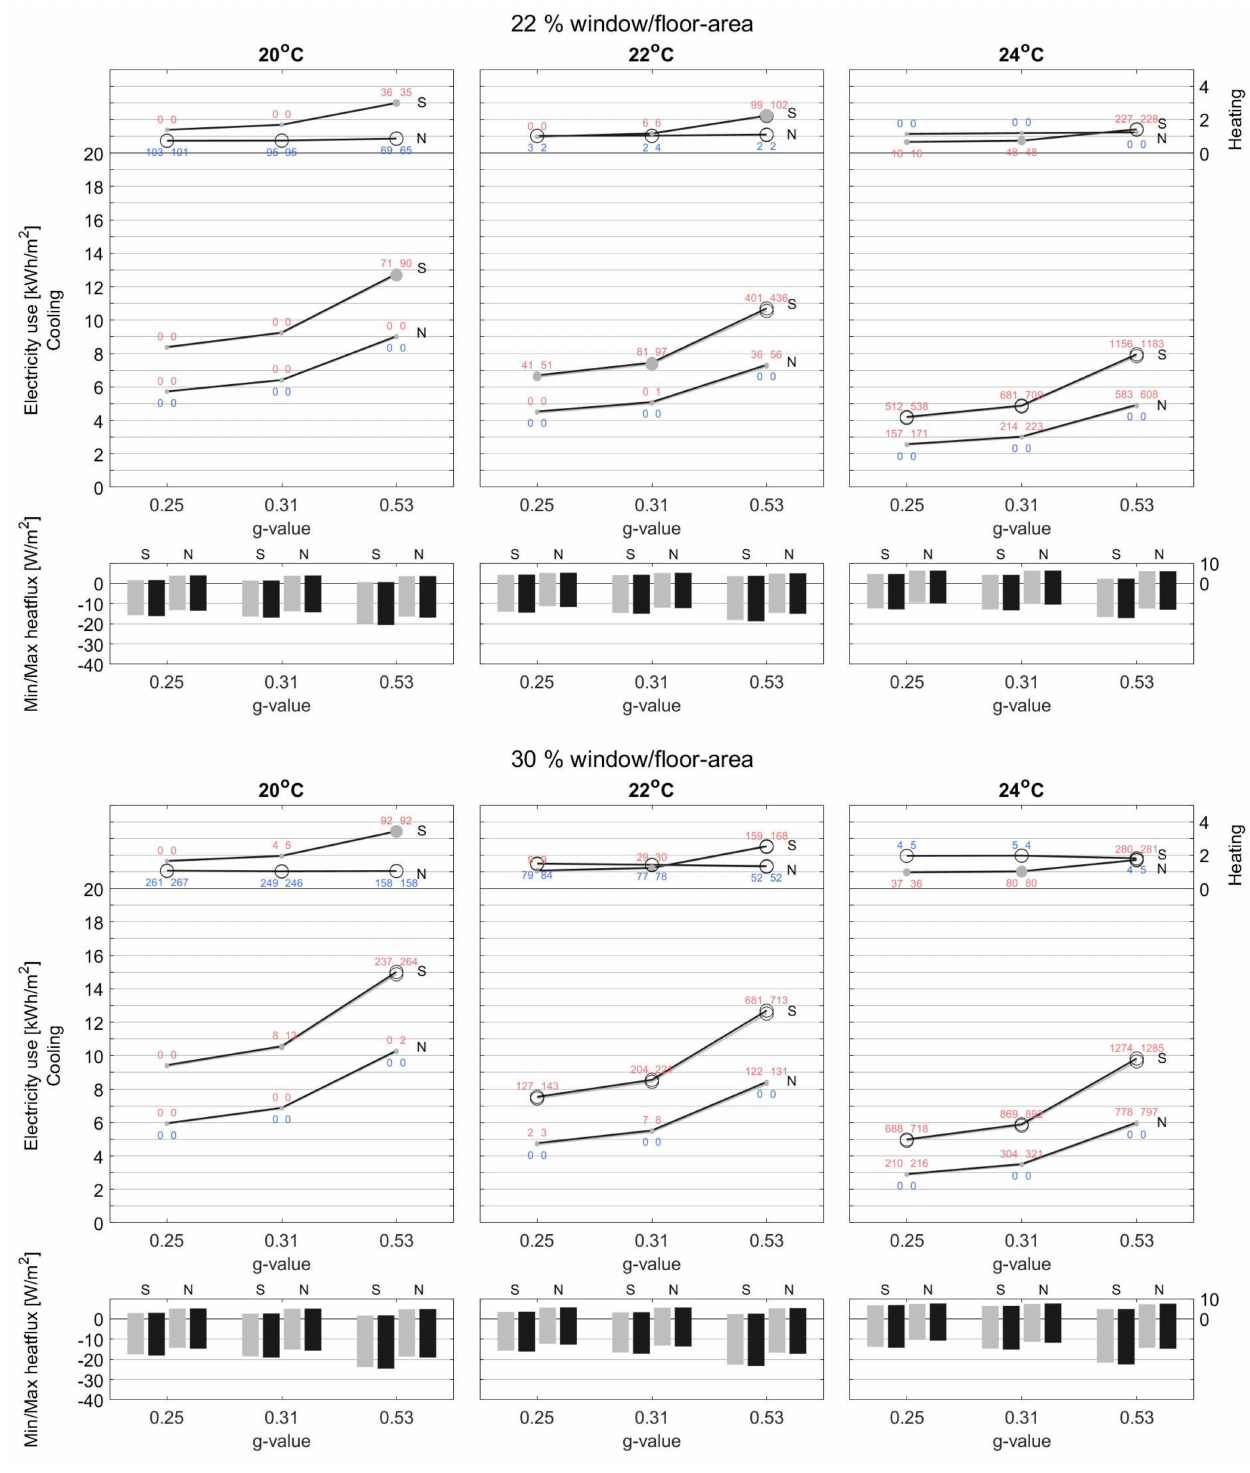
Figure A2. Munich